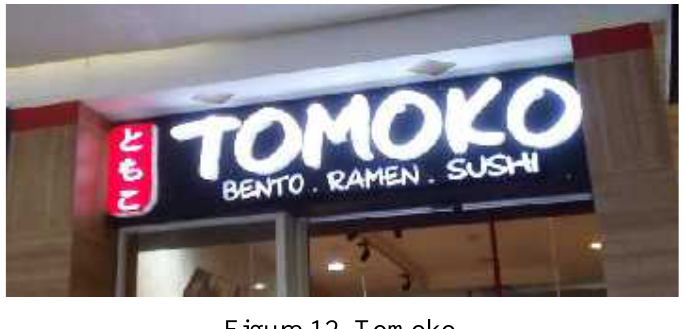
Figure 12. Tomoko